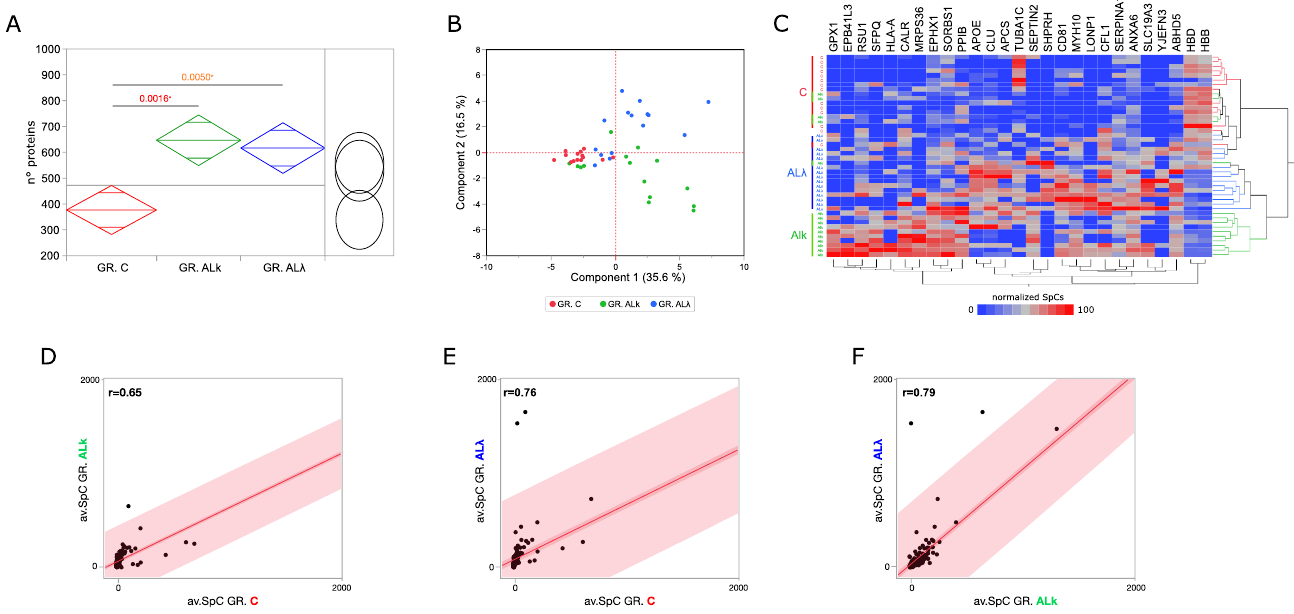
Figure 2. Proteomics analysis of abdominal sub-cutaneous adipose tissues from control subjects and patients affected by AL amyloidosis. ( A ) Comparison among the average number of proteins identified in control subjects (C, n = 14) and patients affected by AL amyloidosis (AL κ , n = 15; AL λ , n = 15); ANOVA and Tukey’s test (* p ≤ 0.05). ( B ) Principal component analysis (PCA) by processing proteins differentially abundant (DAPs) in C, AL κ and AL λ groups. ( C ) Hierarchical clustering and heat map showing the high-confidence DAPs in C, AL κ and AL λ protein profiles (LDA, p ≤ 0.01). ( D ) Spearman’s correlation using DAPs and the corresponding average SpC values in C and AL κ , ( E ) C and AL λ , and ( F ) AL κ and AL λ groups.